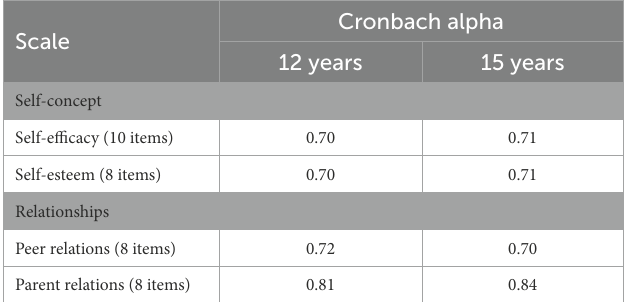
TABLE 4 Timing of outcome measures. Child age in four rounds of data